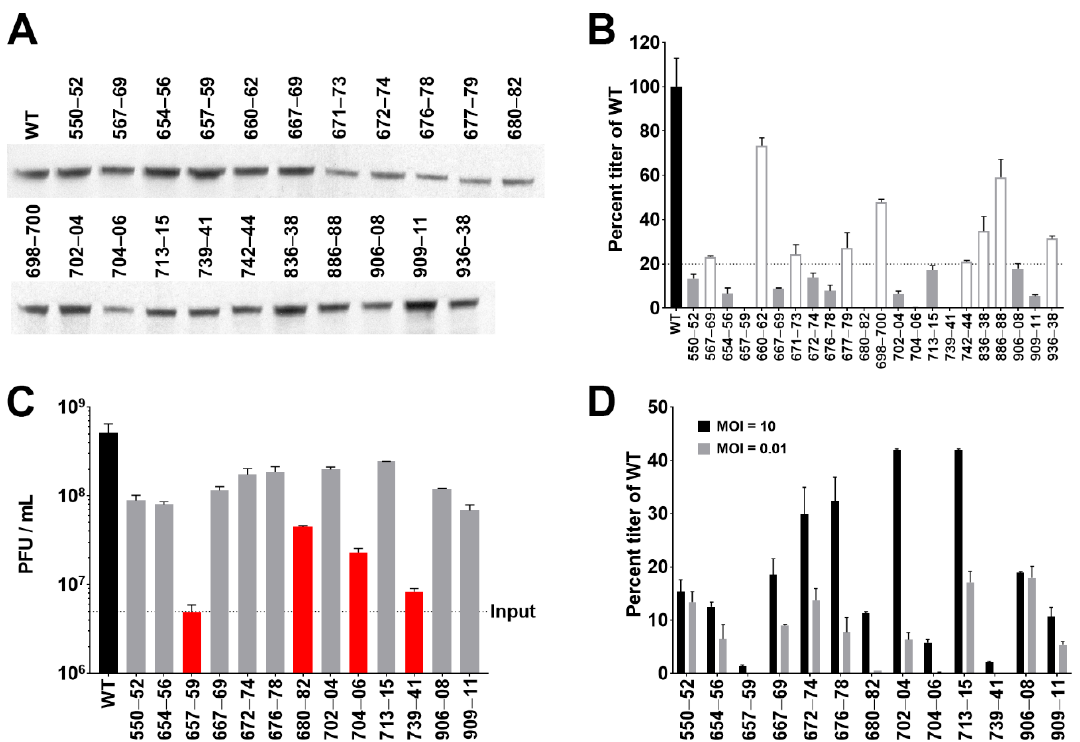
Figure 5. Alanine scanning mutagenesis of conserved amino acids in the C-terminus of pUL37 reveals residues important for productive replication. ( A ) Lysates from Vero cells infected with 22 triple alanine scanning mutants of UL37–EGFP and wild-type (WT) were analyzed by SDS-PAGE, as described in the legend of Figure 2, and the blot of the transferred proteins probed with anti-GFP rabbit antibodies to examine mutant pUL37–EGFP fusion expression. ( B ) Mutant viruses were analyzed for growth on Vero cells following infection of at MOI = 0.01 PFU / cell and titration of the virus burst 3 days post-infection, as described in the legend of Figure 2. Viruses with titers below 20% of WT are shaded grey, and those above 20% open bars. ( C ) The 13 viruses with most reduced titers in a multi-step growth curve were also analyzed for single-step growth by infection at MOI = 10 PFU / cell and harvested 24 h post-infection, as described in the legend of Figure 2. The data for the four most deleterious AAA mutants in the virus are shown as red bars. ( D ) Titers from the 13 viruses analyzed by both single- and multi-step growth are plotted as percent titer of WT for each corresponding experiment. All data represent the mean of at least two independent replicates with error bars of one standard deviation.